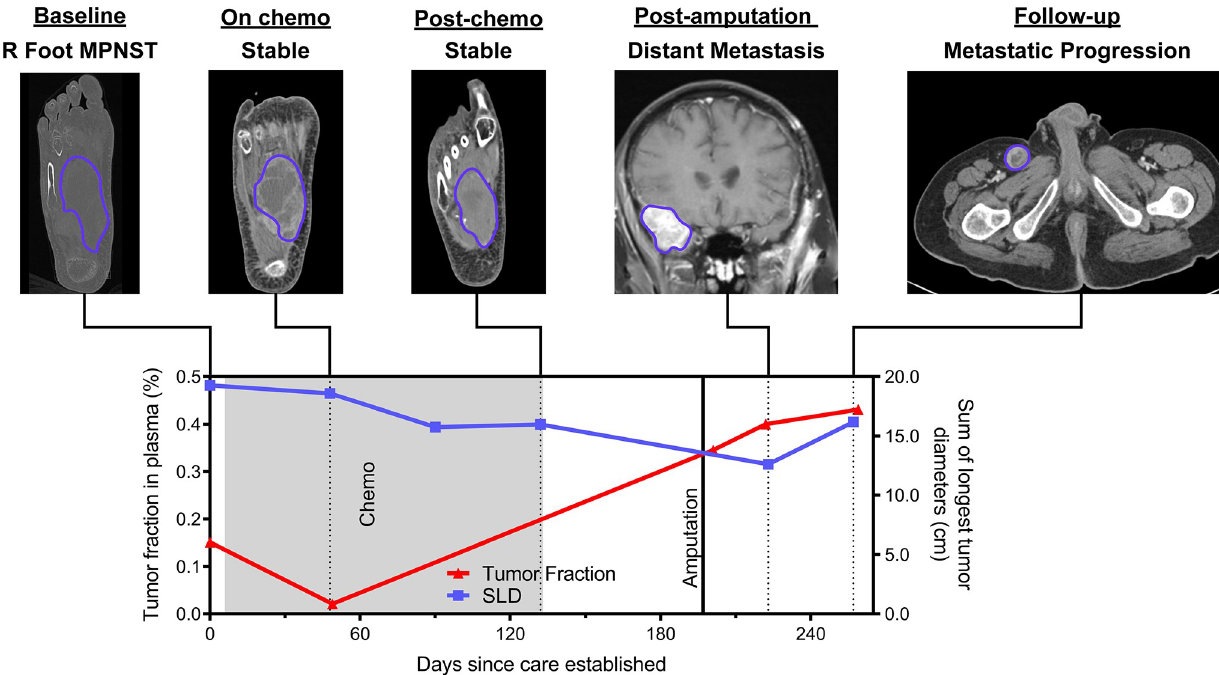
Fig 8. Clinical decision-making vignette (sar102). This patient had a high-grade MPNST in the right foot that was stable by imaging and therefore had chemotherapeutic agents held in order to undergo an elective lower limb amputation for improved quality of life. Tumor fraction in plasma, however, increased during this presurgical time period, consistent with progressive metastatic disease, which became apparent on imaging shortly after surgery. The patient would not have had chemotherapy held to undergo lower limb amputation had there been earlier evidence of progressive metastatic disease. Chemo, chemotherapy; cm, centimeters; MPNST, malignant peripheral nerve sheath tumor; SLD, sum of longest tumor diameters as determined by RECIST 1.1 criteria.